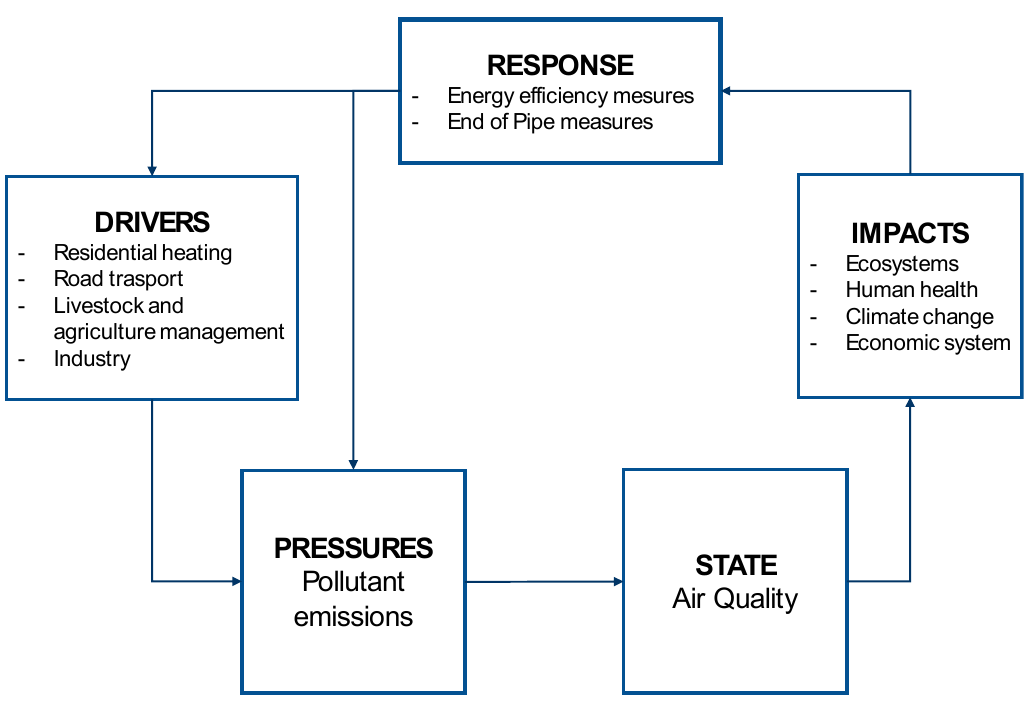
Figure 1. DPSIR framework adapted for the Multi ‐ dimensional Air Quality (MAQ) system.